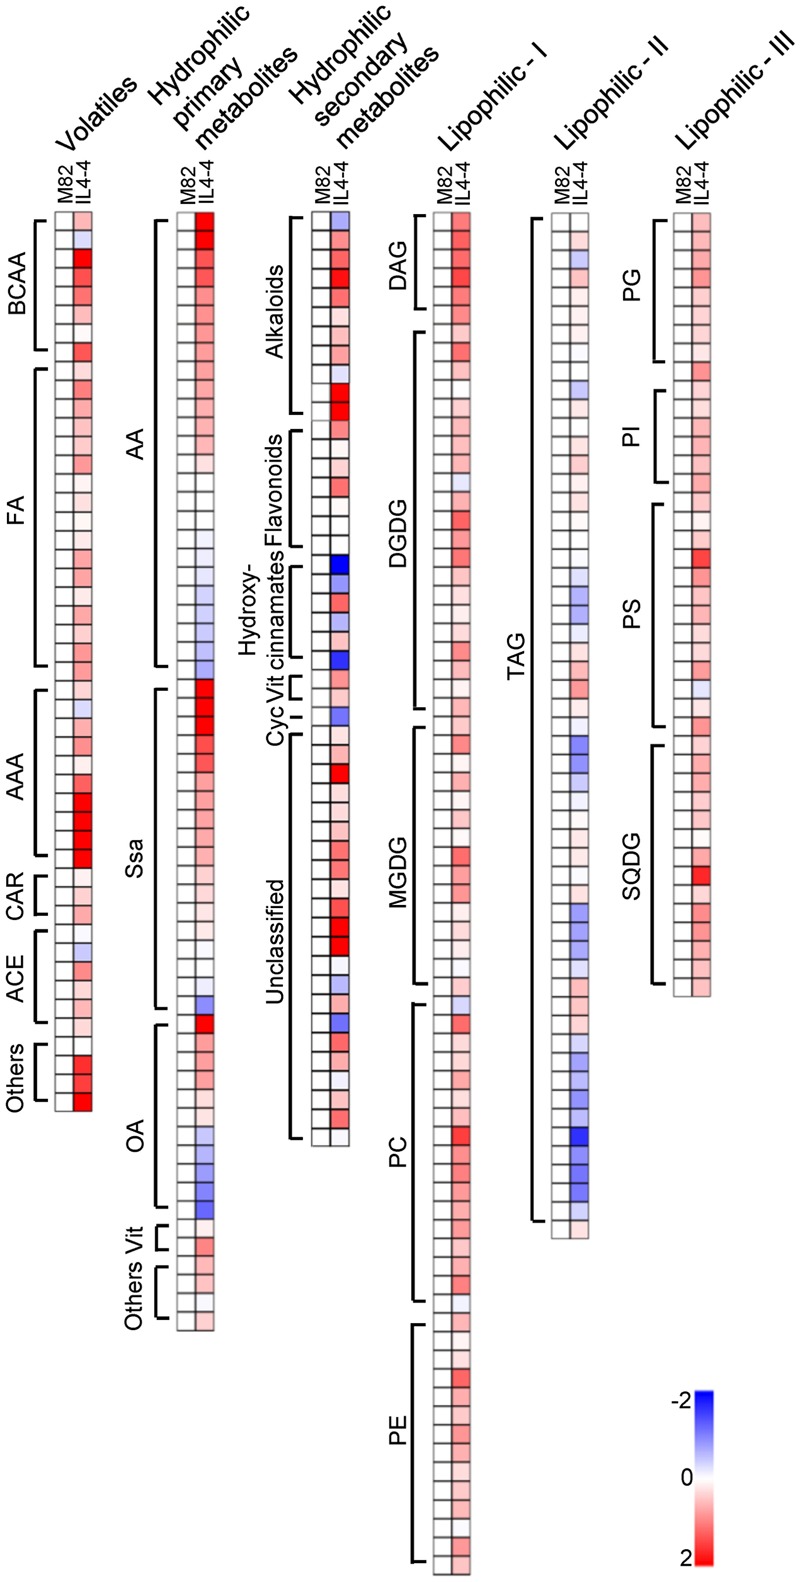
Heat map of IL4-4 fruit metabolites compared to M82. BCAA, branched-amino acids; FA, fatty acids; AAA, aromatic-amino acids; CAR, carotenoid; ACE, acetate; AA, amino acids; Ssa, Sugars and sugar alcohols; OA, organic acids; Vit, vitamins; Cyc, cyclitol; Alk, alkaloids; DAG, diacylglycerol; DGDG, digalactosyl-diacylglycerol; MGDG, monogalactosyldiacylglycerol; PC, phosphatidylcholine; PE, phosphatidylethanolamine; TAG, triacylglyceride; PG, phosphatidylglycerol; PI, phosphatidylinositol; PS, phosphatidylserine; SQDG, sulfoquinovosyldiacylglycerol.